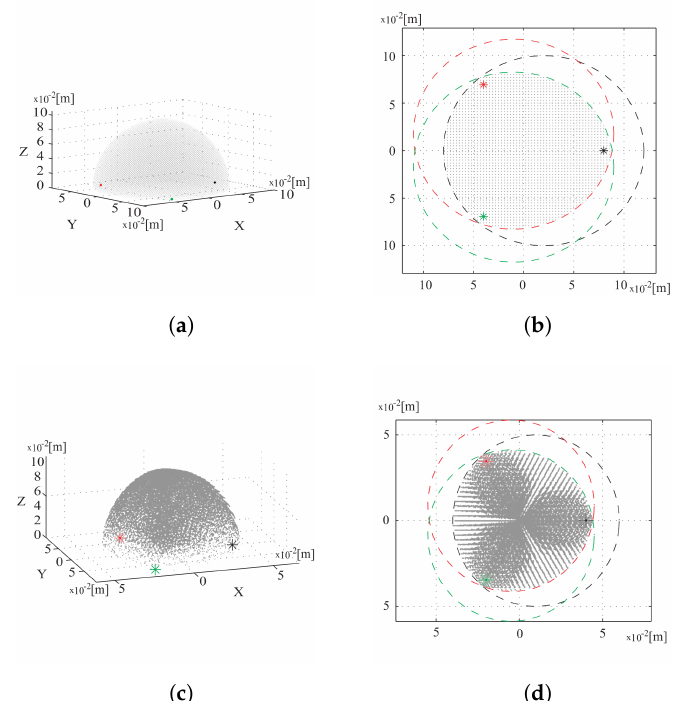
Figure 5. Workspace of the first mini-manipulator, with the feet of first, second and third leg in black, red and green respectively. From the left, three-dimensional and upper vision of the workspace in the ideal case for ( a , b ), and as evaluated according to hinges constraints for ( c , d ).